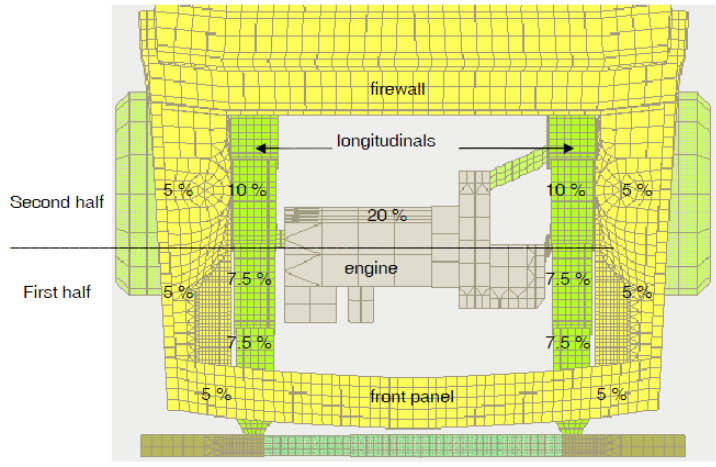
Figure 2. Estimated energy absorption percentages in the frontal structure of an automobile.